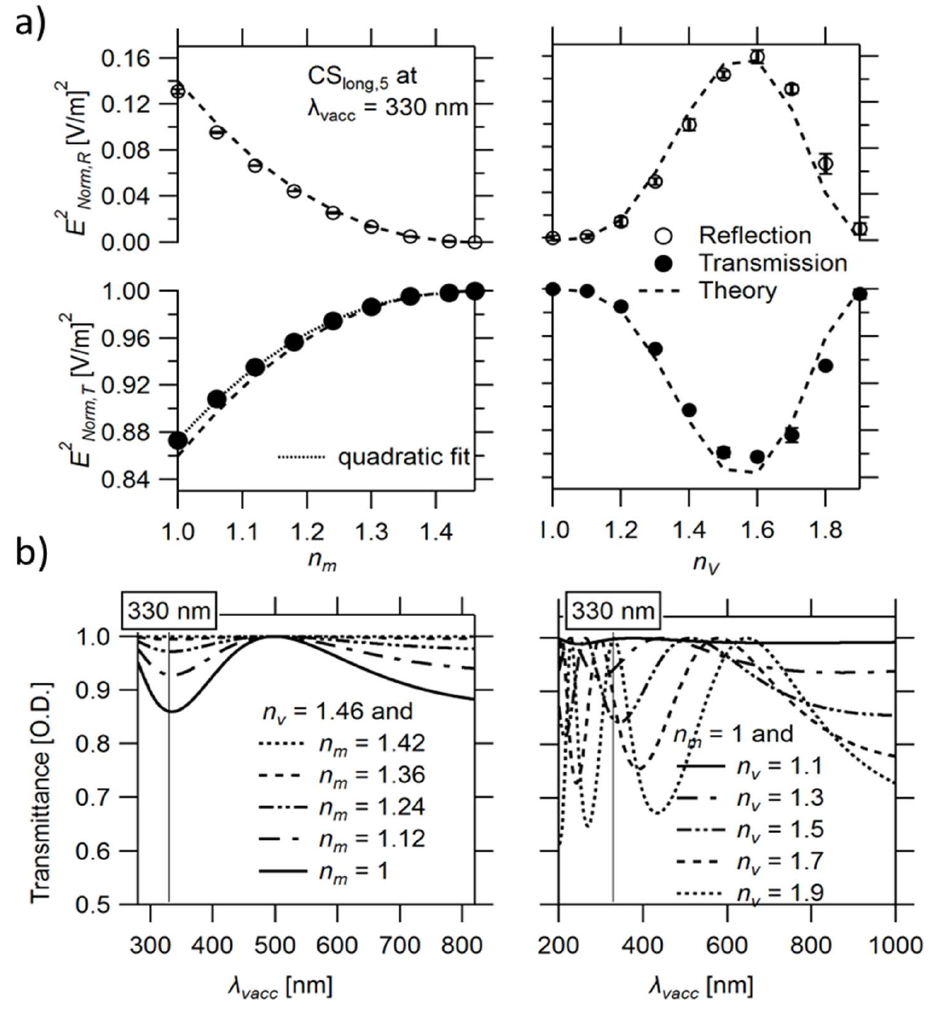
Figure 4. ( a ) The change of E 2Norm (i.e., intensity) of the reflected and transmitted wave by CS long,5 at λ vacc = 330 nm vs. changing n m (left) or n v (right) compared to theoretical calculations. ( b ) The change of transmission spectra vs. changing n m (left) or n v (right), based on theoretical calculations.